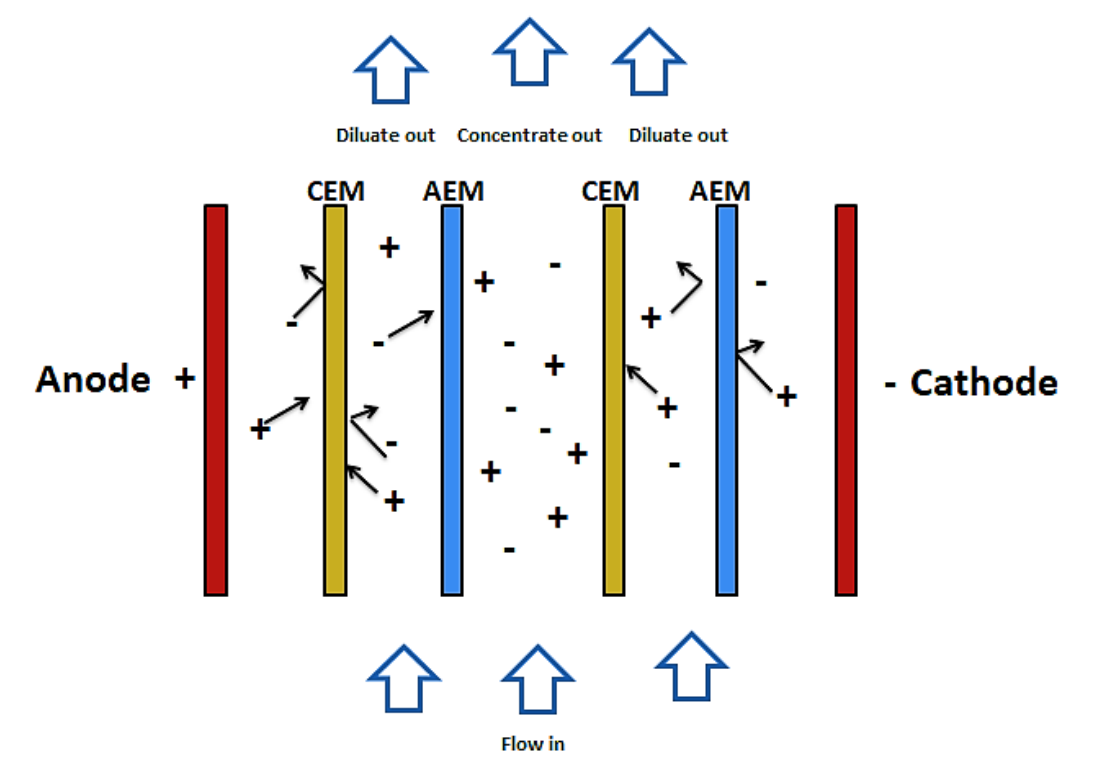
Figure 3. Schematic diagram of ED.